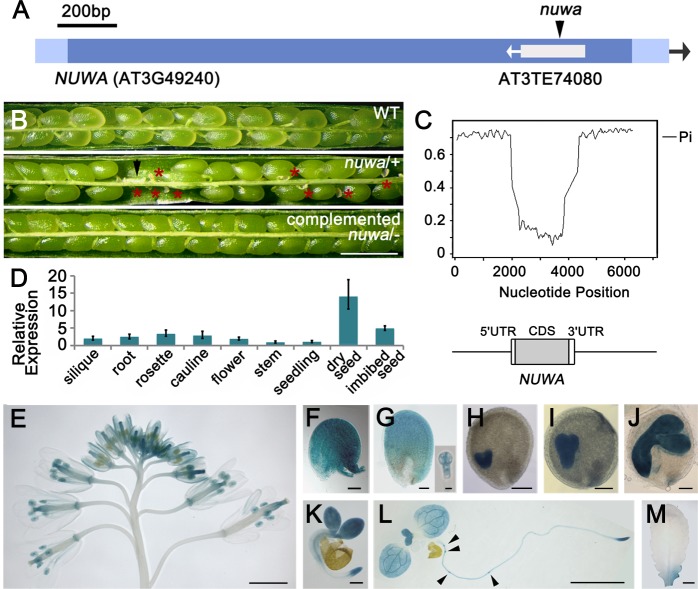
NUWA is mainly expressed in reproductive organs.(A) The T-DNA insertion sites in nuwa/+. (B) Siliques of wild type (upper), nuwa/+ (middle) and complemented nuwa/- (lower). Red stars and the black arrow indicate early and late aborted seeds, respectively. Bar = 1 mm. (C) Nucleotide diversity in the genomic region centered on NUWA among 5 Brassicaceae species, i.e., A. thaliana, A. lyrata, C. rubella, B. rapa and E. salsugineum. (D) Real-time qPCR analysis of NUWA in various tissues. Error bars, mean ± SD. (E-M) GUS staining patterns in inflorescence (E), ovule before fertilization (F), ovule at 2–4 cell embryo stage (G), ovules at heart (H), torpedo (I), walking-stick (J) embryo stages, germinated seeds (K), 10-day-old seedlings (L) and rosette leaf (M) in pNUWA:NUWA-GFP-GUS transgenic plants. Arrowheads indicate lateral root primordia. Bars = 2 mm (E, L, M), 50 μm (F, G), 100 μm (H-J), 200 μm (M) or 10 μm (small figure in G).